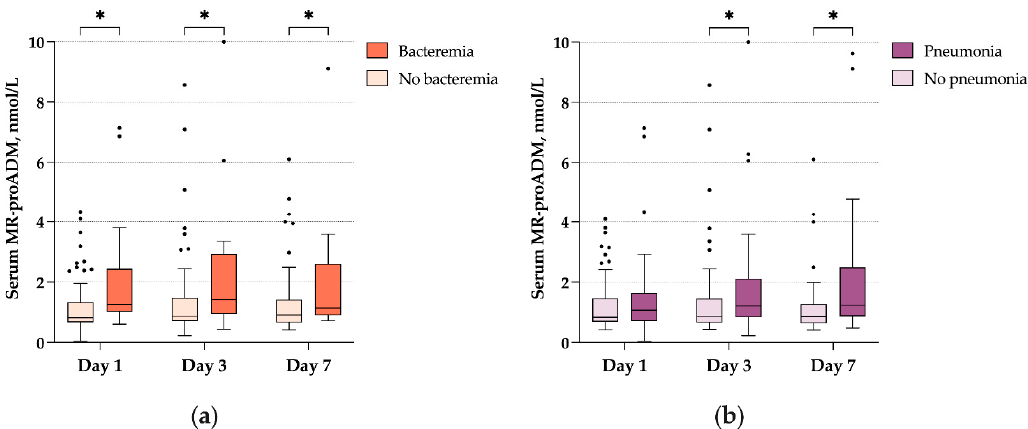
Figure 4. ( a ) MR-proADM concentrations according to the occurrence of pneumonia on days 1, 3, and 7. ( b ) MR-proADM concentrations according to the occurrence of pneumonia on days 1, 3, and 7. Abbreviations: MR-proADM, Mid-regional proadrenomedullin. * p < 0.05.